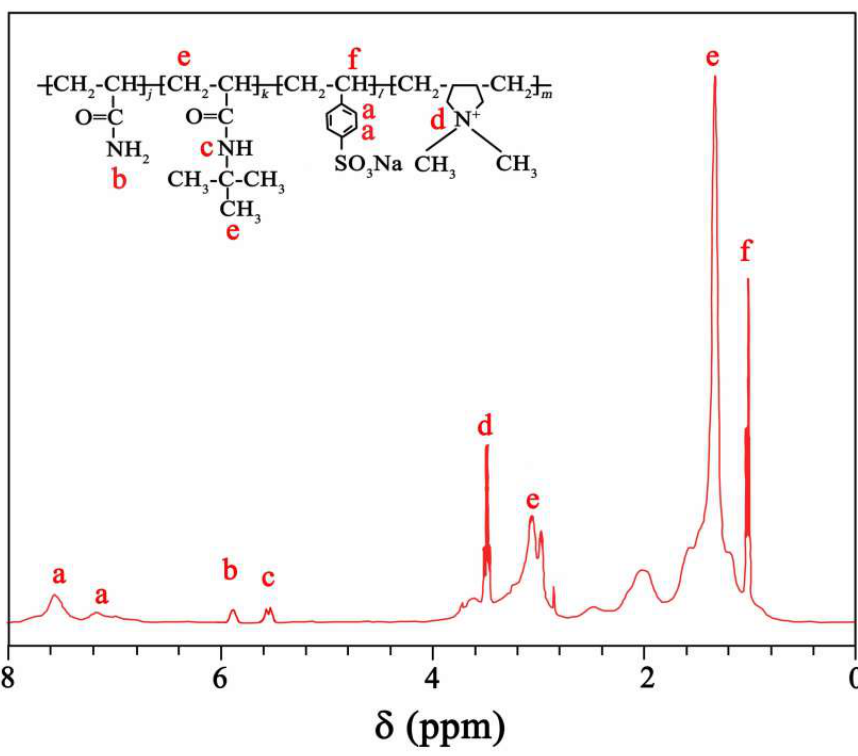
Figure 3. 1 H − NMR spectrum of quadripolymer (AM/AMPS/DMDAAC/SSS). Figure 3. 1 H−NMR spectrum of quadripolymer(AM/AMPS/DMDAAC/SSS). From the TG curve (Figure 4), it can be found that the four stages of the thermal degradation process, first stage, the quadripolymer has 8.5% of mass losses before 260 ◦ C, indicating slightly thermal degradation from chain scissionThe second stage is from 260 ◦ C to 319.5 ◦ C, apparent mass loss of the quadripolymer occurs (27.71%) in the TG curve and the fastest mass loss temperature emerges at 300.5 ◦ C in the DSC curve. The third stage is from 319.5 ◦ C to 528.5 ◦ C, the mass loss declines constantly (35.43%). the release of the non- cyclic anhydrides formation acrylic acid repeat unit or the carboxylic acid pendant group. Moreover, accordingly, there is no significant fluctuation on the DSC curve. The last stage is from 528.5 ◦ C to 600 ◦ C, 28.36% mass is left. This might be due to the thermal degradation of C=C decomposition in the main chain of AM and SSS segments and the breakage of benzene ring in SSS monomers. From the above analysis, the thermal degradation of the quadripolymer is not obvious before 260 ◦ C and only 27.7%, which demonstrates the quadripolymer has strong heat-resistance